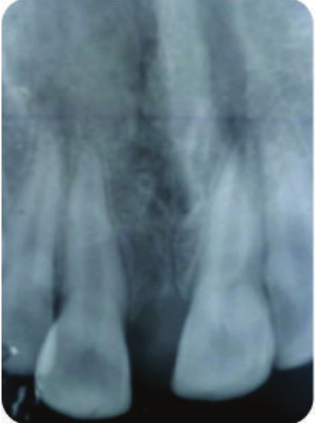
Figure 3: Rarefaction of bone on the mesial aspect of the cervical and middle third of the root of 11.